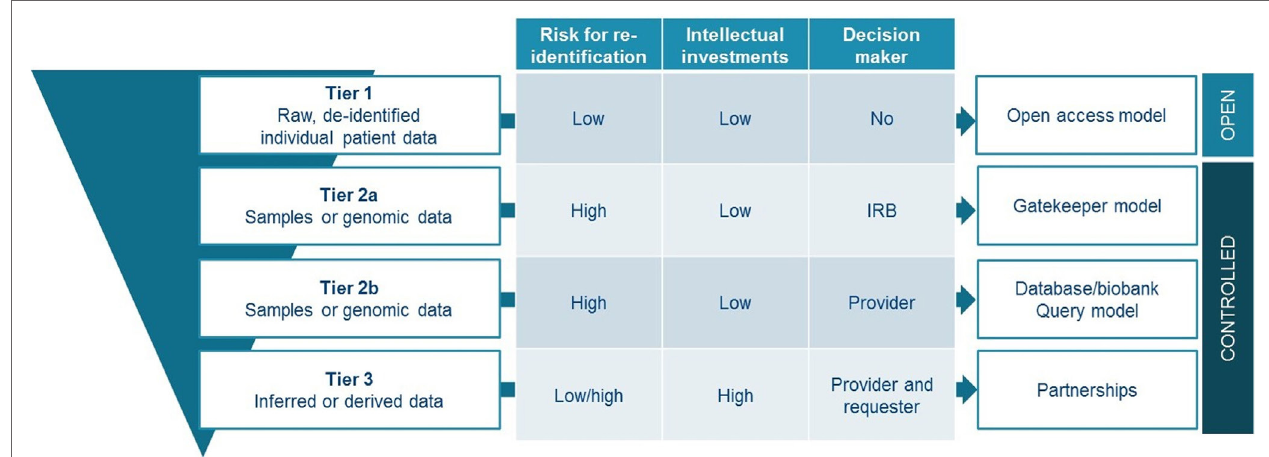
FigUre 3 | Proposed tiered-layered model to share and access clinical data and